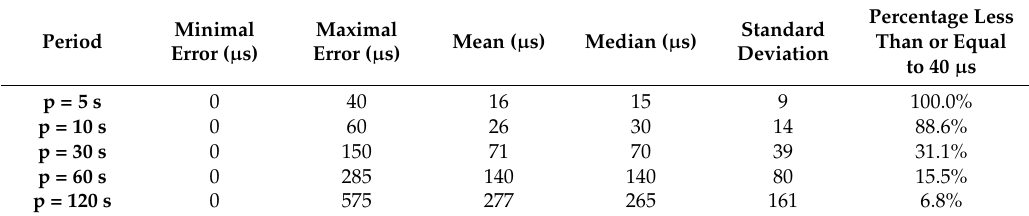
Table 2. Results obtained in the precision experiment, for internal clock synchronization.